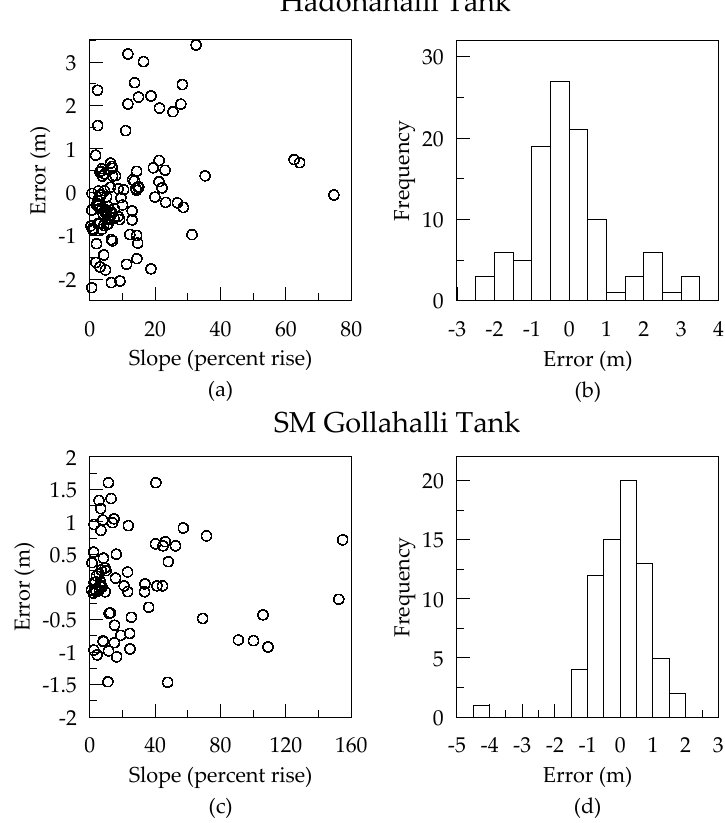
Figure 10. ( a , c ) show the error of each validation point plotted against the terrain slope (in percent rise) for each tank. ( b , d ) are histograms of the elevation error for 72 validation data points at SM Gollahalli tank and 105 validation points Hadonahalli tank. Bin widths of 0.5 m were used for each tank. The average absolute error was also compared for surface data collected from only the UAV versus the USV. Because SM Gollahalli tank was the only partially-wetted site for which the UAV and USV data were fused, this comparison was performed only for that tank. The average absolute error is 0.613 m for validation data points that were measured in locations corresponding to UAV-only